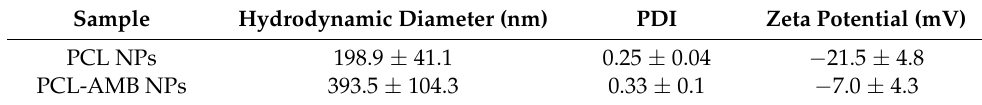
Figure 2. The hydrodynamic diameter of PCL NPs (blue line) and PCL-AMB NPs (red line) ( A ). Zeta potential of PCL NPs (blue line) and PCL-AMB NPs (red line) ( B ). UV-Vis spectra of PCL NPs in MQ water (blue line), AMB in DMSO (green line), and PCL-AMB NPs in DMSO (red line) ( C ). Table 1. Hydrodynamic and Zeta potential of PCL NPs and PCL-AMB NPs.